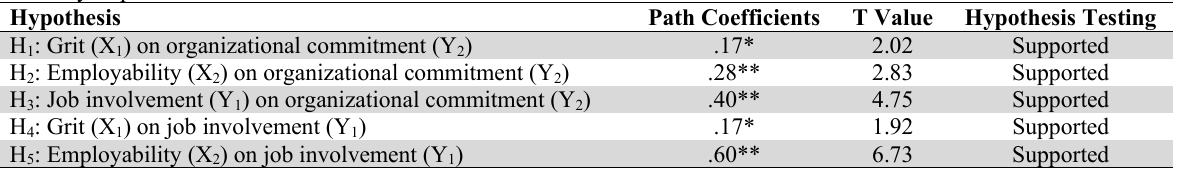
Summary of path coefficients and t